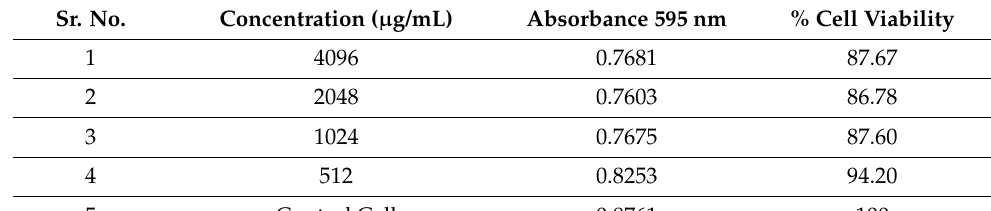
Table 1. In vitro cytotoxicity analysis of heraclenol. Sr. No.